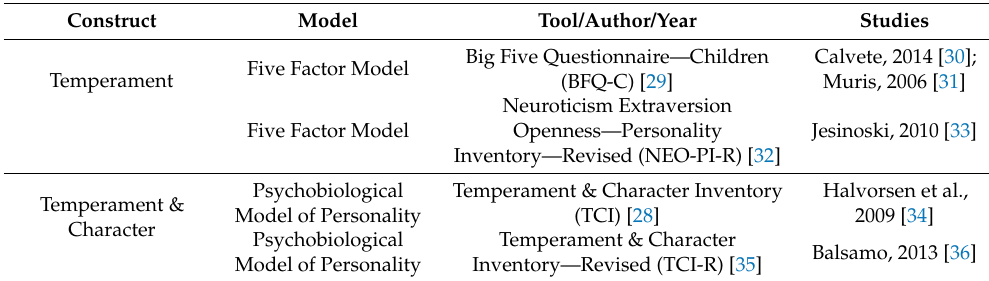
Table 3. Summary of studies in scoping review examining